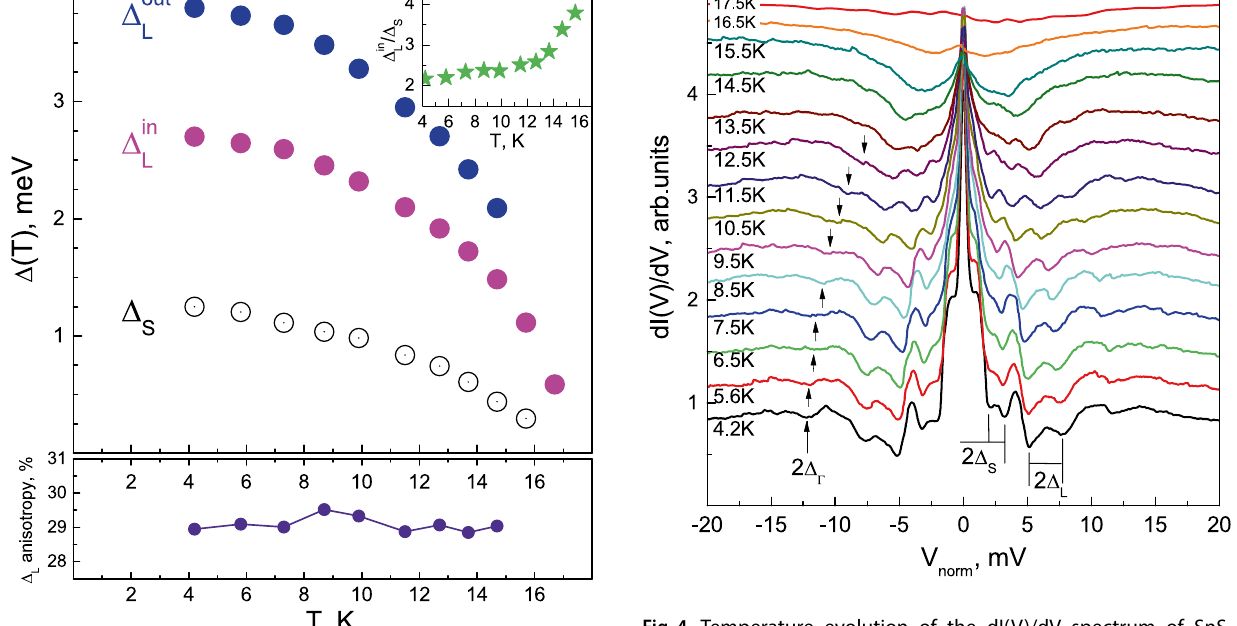
Fig. 4 Temperature evolution of the dI(V)/dV spectrum of SnS– Andreev array ( m = 2 junctions). The monotonic normal-state background is suppressed. T local c ≈ 17.5 K. The normal conduct- ance G ( V > 10 mV ) → G N is constant with temperature; the dI(V)/ dV curves are manually shifted along the vertical axis for clarity. For the lowest curve (4.2 K), the vertical dashes point to the positions of the fundamental Andreev dips of three superconducting gaps, Δ Δ L , and Δ S . V norm ≡ V ∕ Γ , Δ in L ( T ) ] Δ out L ( T ) | |